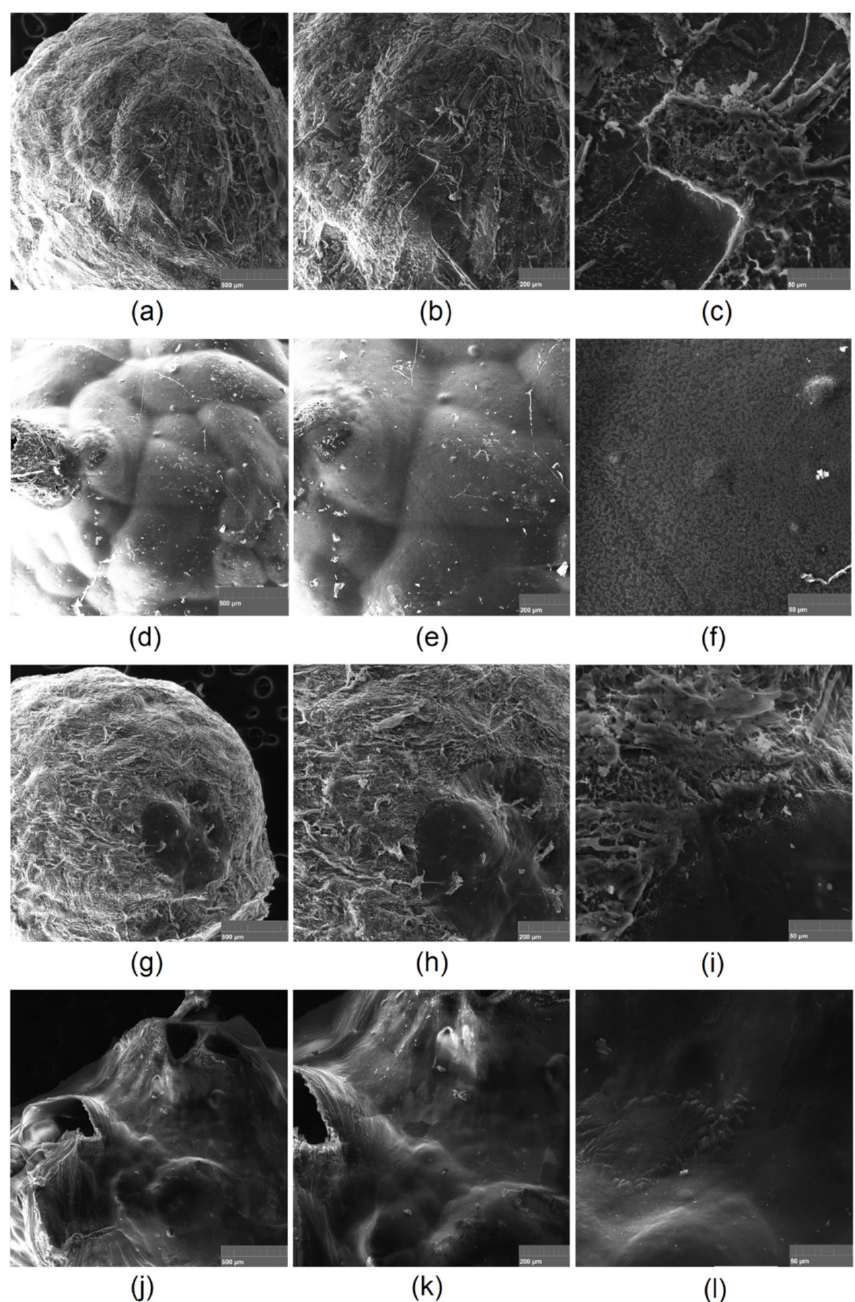
Figure 14. SEM microphotographs of the chitosan-based beads: ( a ) Gel-1-B 500 × ; ( b ) Gel-1-B 1000 × ; ( c ) Gel-1-B 5000 × ; ( d ) Gel-2-B 500 × ; ( e ) Gel-2-B 1000 × ; ( f ) Gel-2-B 5000 × ; ( g ) Gel-3-B 500 × ; ( h ) Gel-3-B 1000 × ; ( i ) Gel-3-B 5000 × ; ( j ) Gel-4-B 500 × ; ( k ) Gel-4-B 1000 × ; ( l ) Gel-4-B 5000 ×